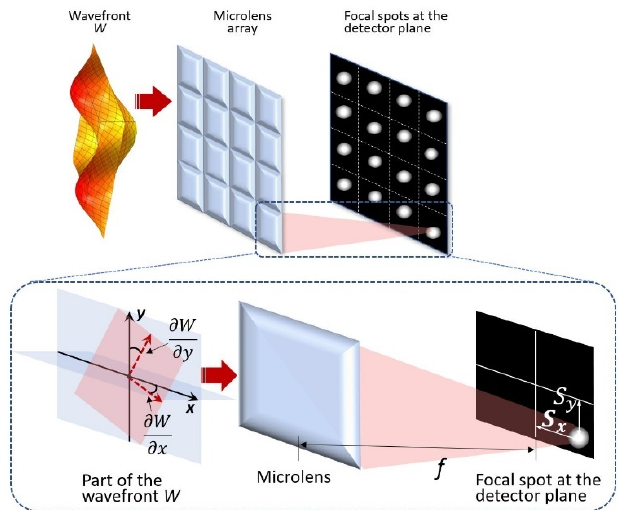
Figure 3. Principle of Shack-Hartmann technique—calculation of wavefront slopes based on focal spots displacements.